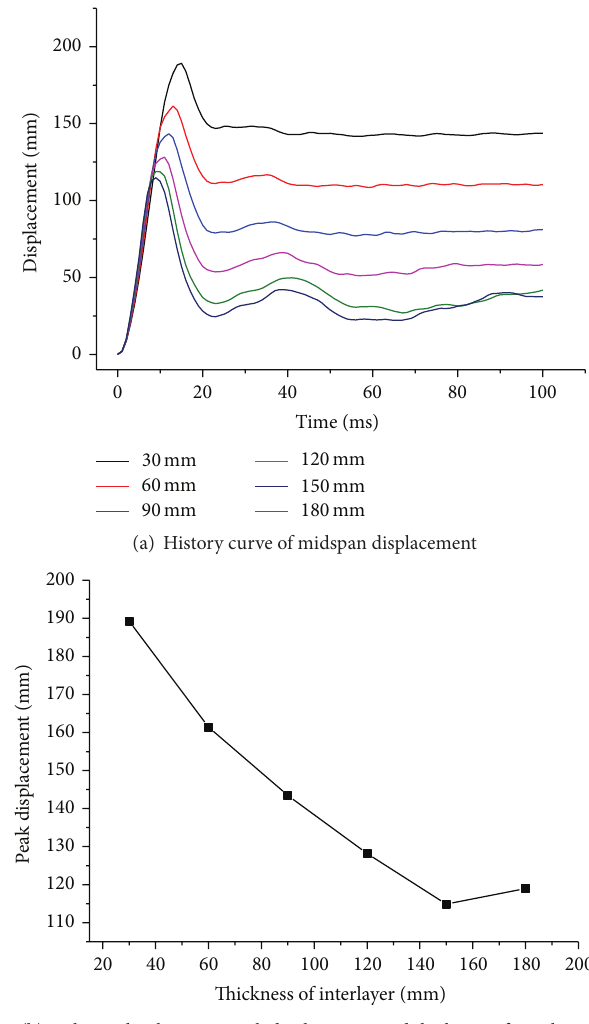
Figure 8: Effect of interlayer thickness on the displacement of blast